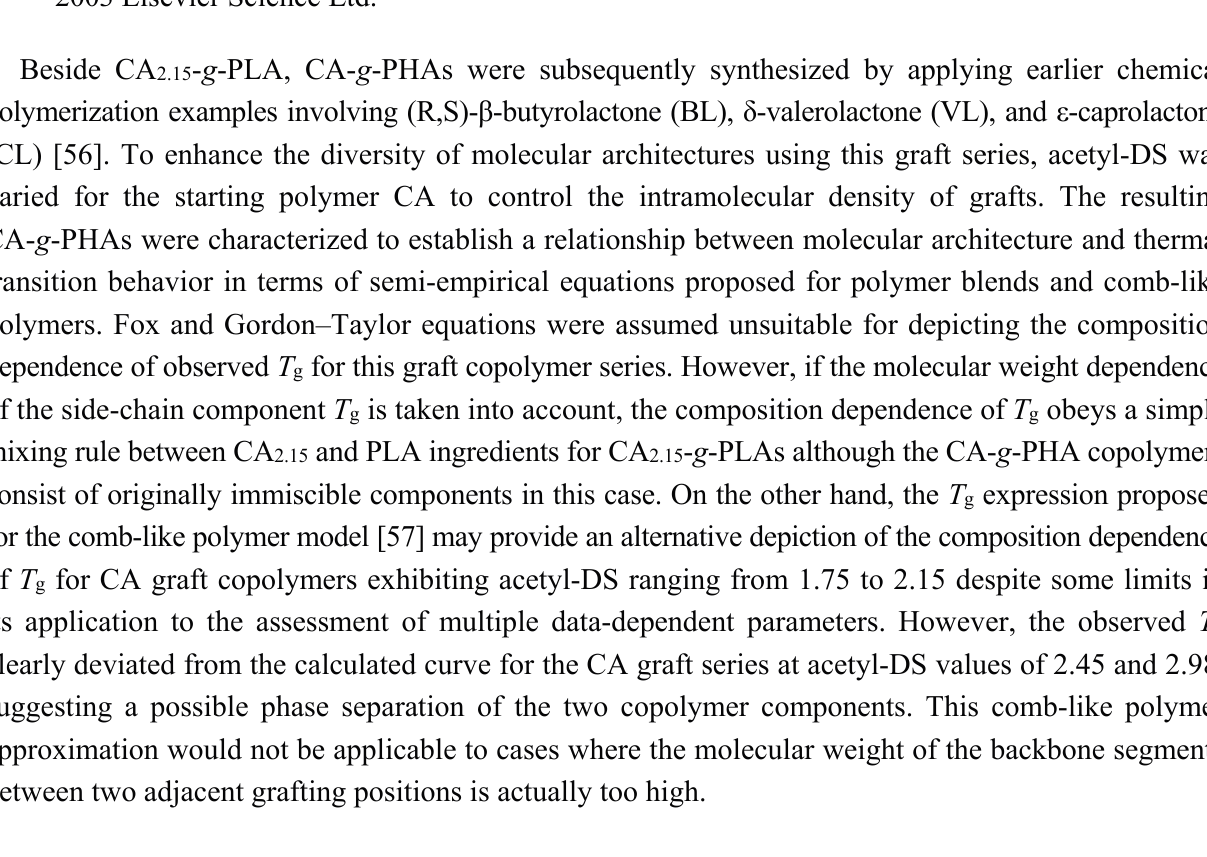
Figure 17. 1 H-NMR spectrum of a CA- g -PLA for which acetyl-DS = 2.15, MS = 7.86, DPs = 8.93, and lactyl DS = 0.88. Reproduced with permission from ref. [55]. Copyright 2003 Elsevier Science